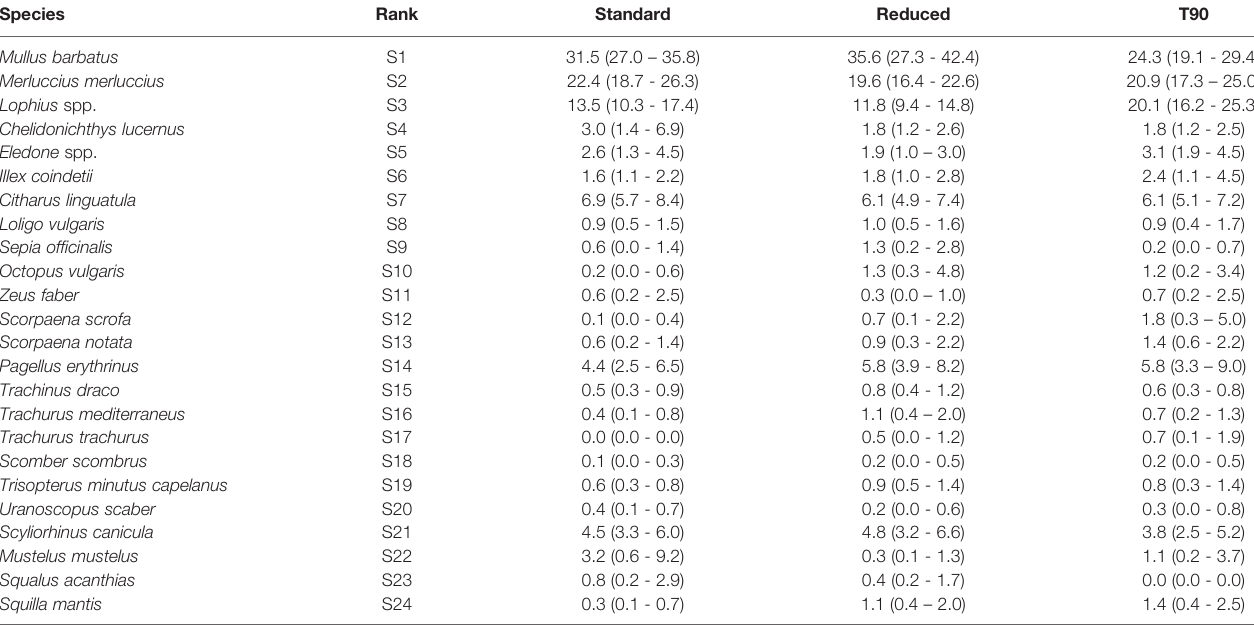
Values in brackets represent the lower and upper 95% CIs